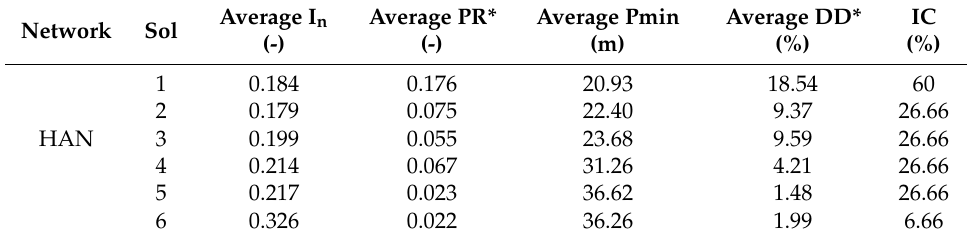
Table 10. Average characteristics of HAN solutions among all of the